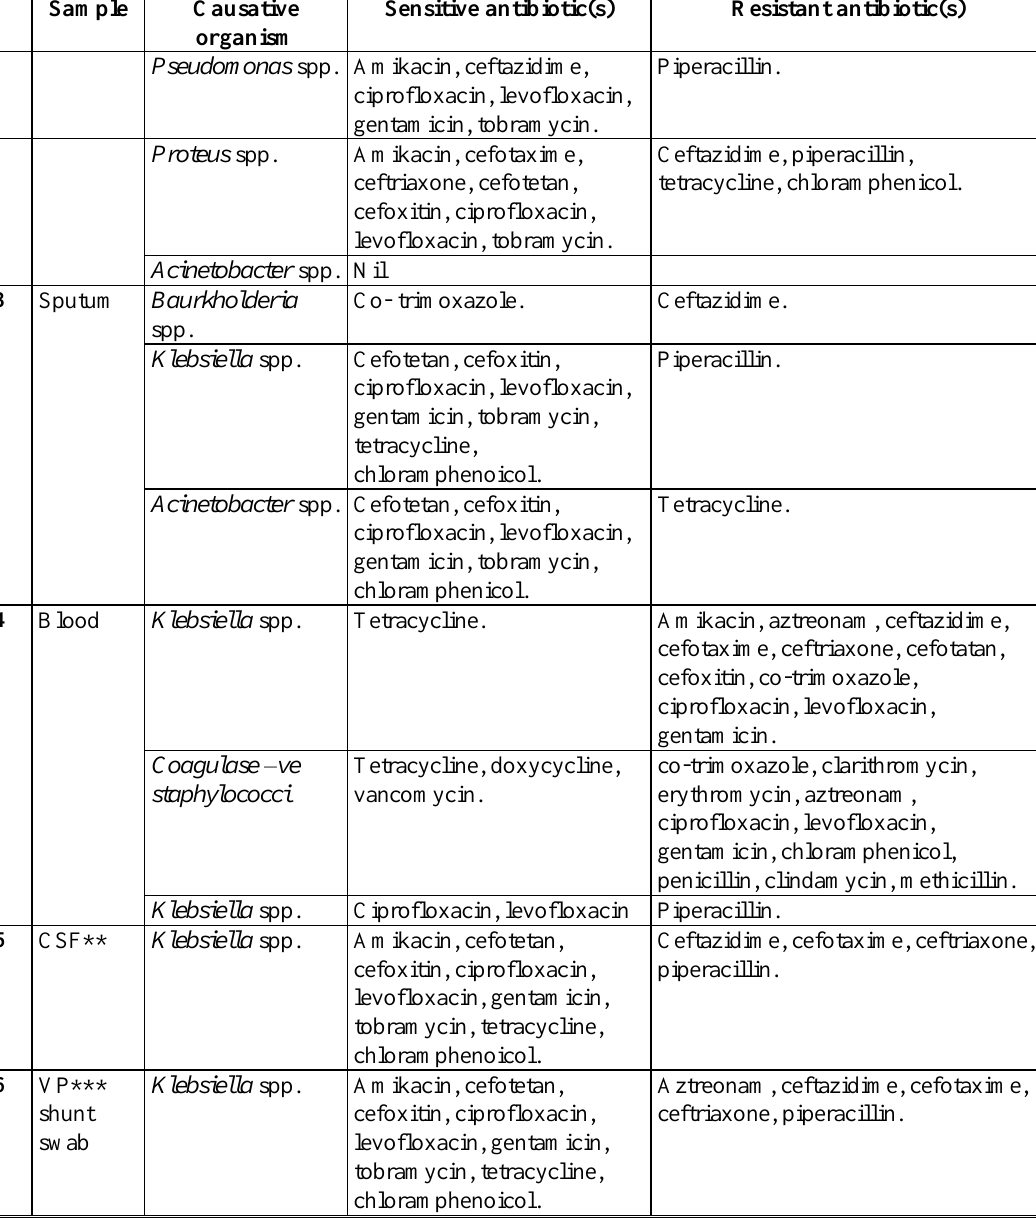
Table (4): (Continued) causative bacteria isolated from patients and their sensitivity to antibiotics in each sample in the